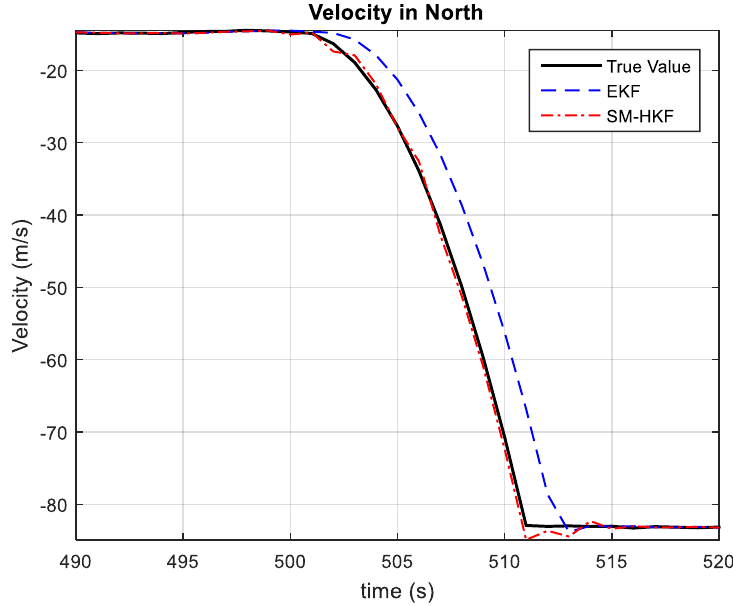
Figure 6. The velocities in North estimated by EKF and SM-HKF from 490 s to 520 s.